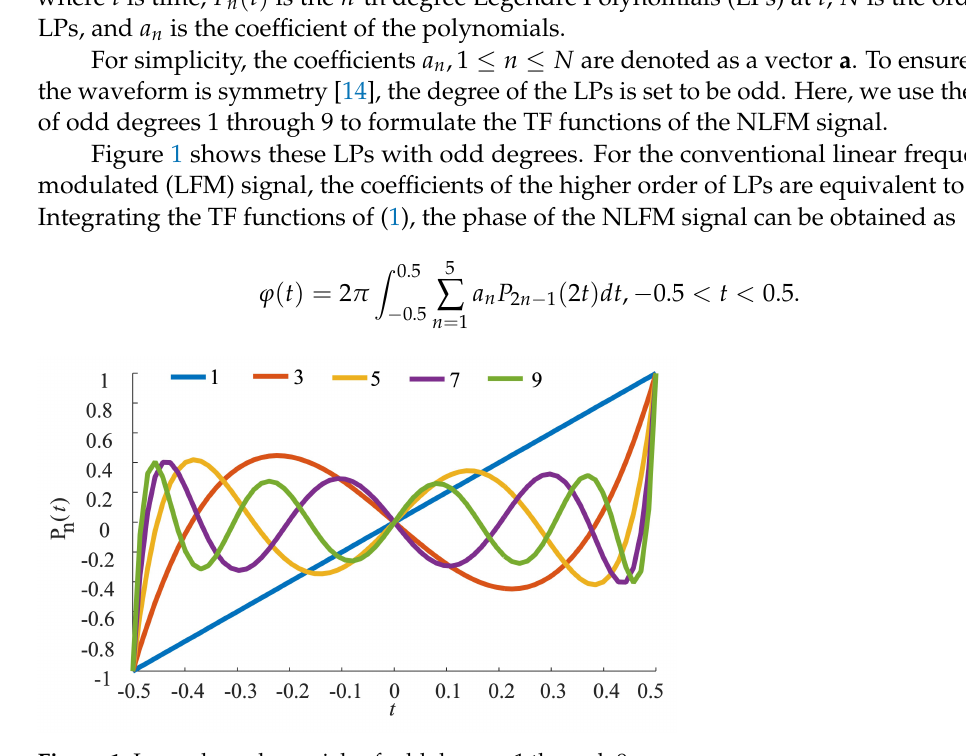
Figure 1. Legendre polynomials of odd degrees 1 through